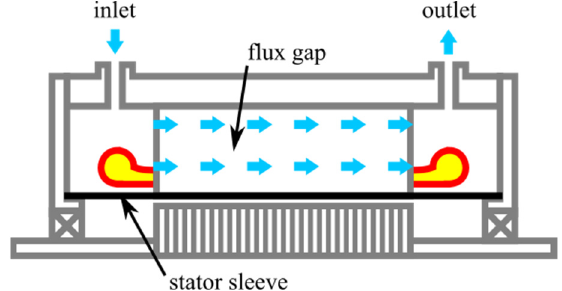
Figure 19. Flooded stator concept [109].